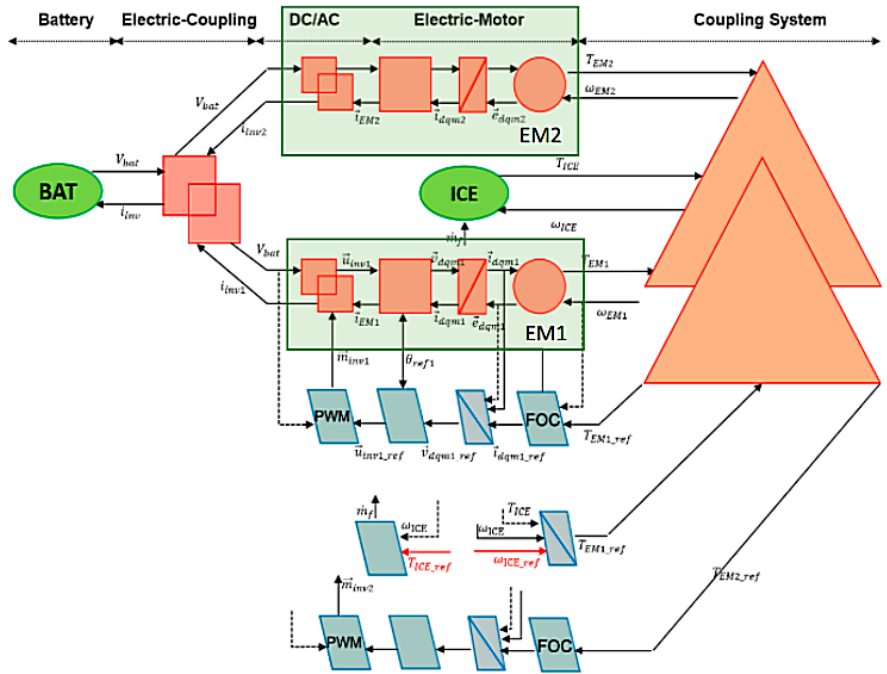
Figure 6. EMR structure for multi-architectures.